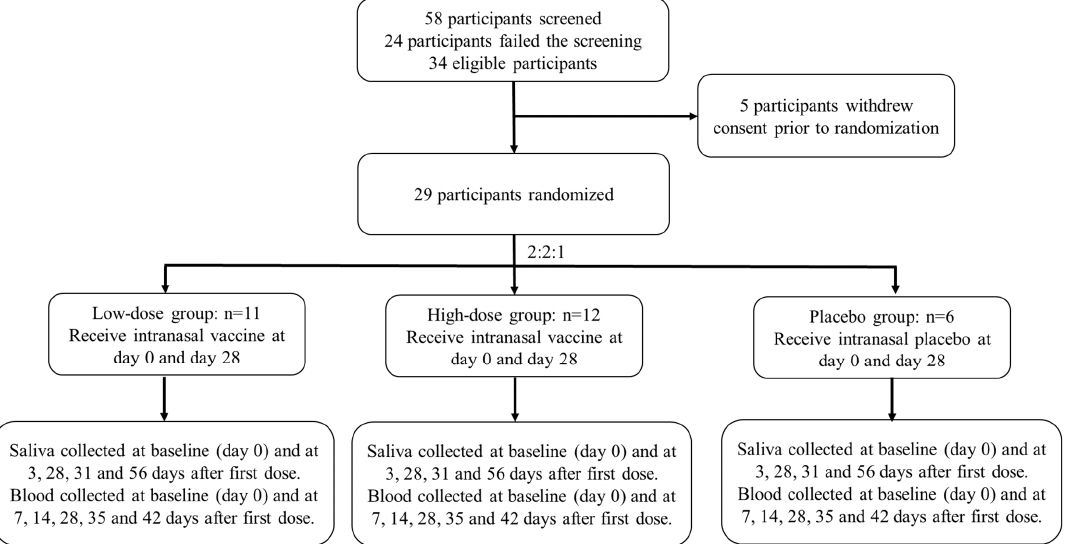
Figure 2. Overview of participants’ allocation. High-dose: DelNS1-nCoV-RBD LAIV (1 × 10 7.7 EID 50 /dose) in 0.2 mL. Low-dose: DelNS1-nCoV-RBD LAIV (1 × 10 7 EID 50 /dose) in 0.2 mL. Placebo: inert excipients/dose in 0.2 mL. Table 1. Demographic and baseline characteristics.